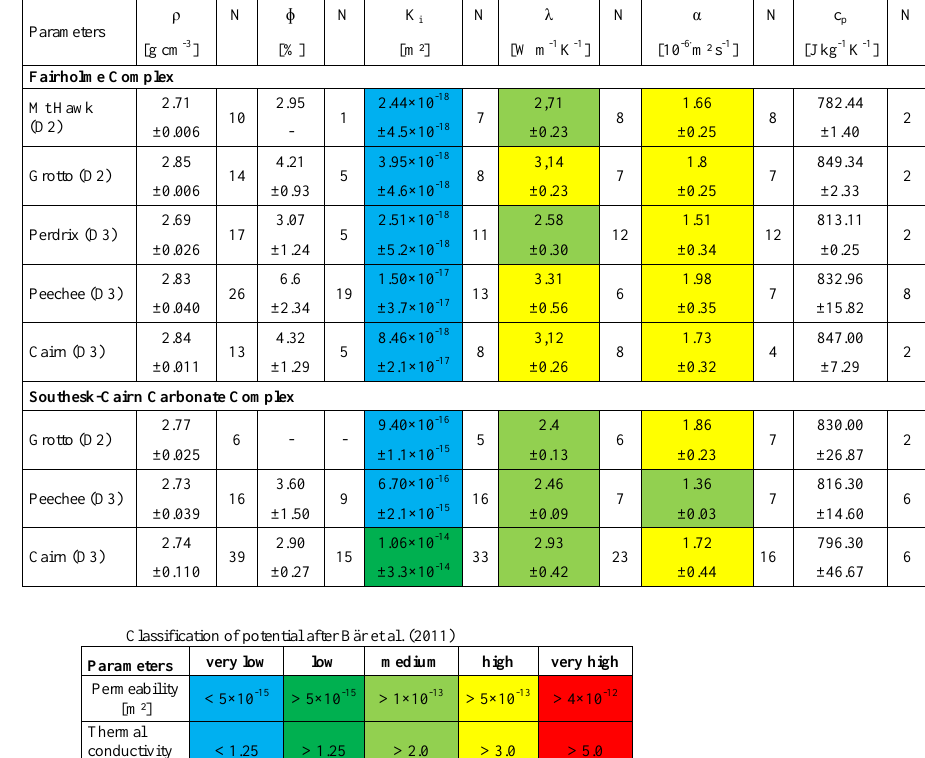
Table 2. Rock properties of outcrop analogue samples. Table 2: Rock properties of outcrop analogue